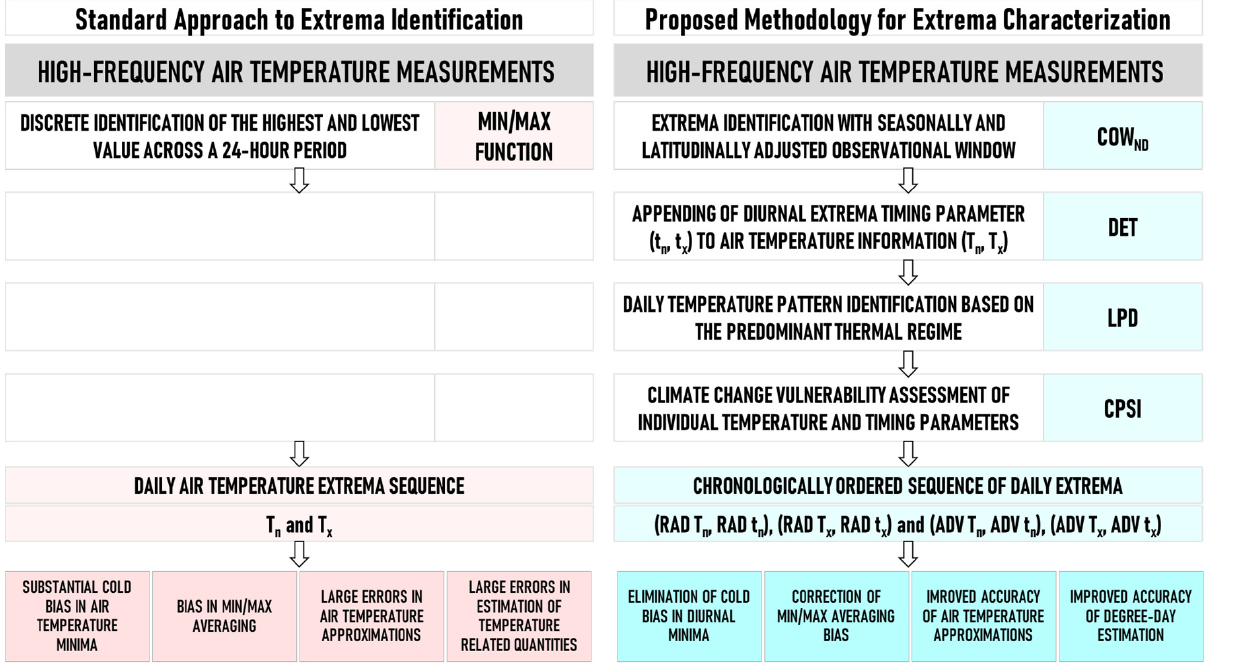
Figure 1. Comparison of the standard approach for extrema identification with the new multi-step methodology for extrema characterization.